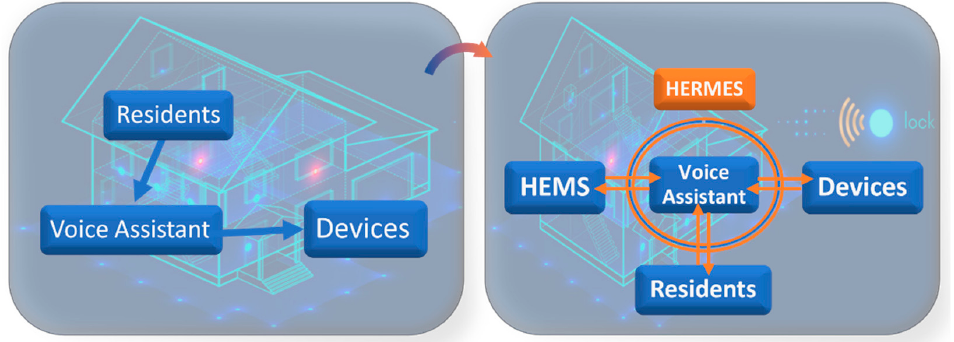
Figure 3. HERMES: Bi-directional dual-channel formed between HEMS-Voice Assistant-Residents. Background: © 123fr.com.